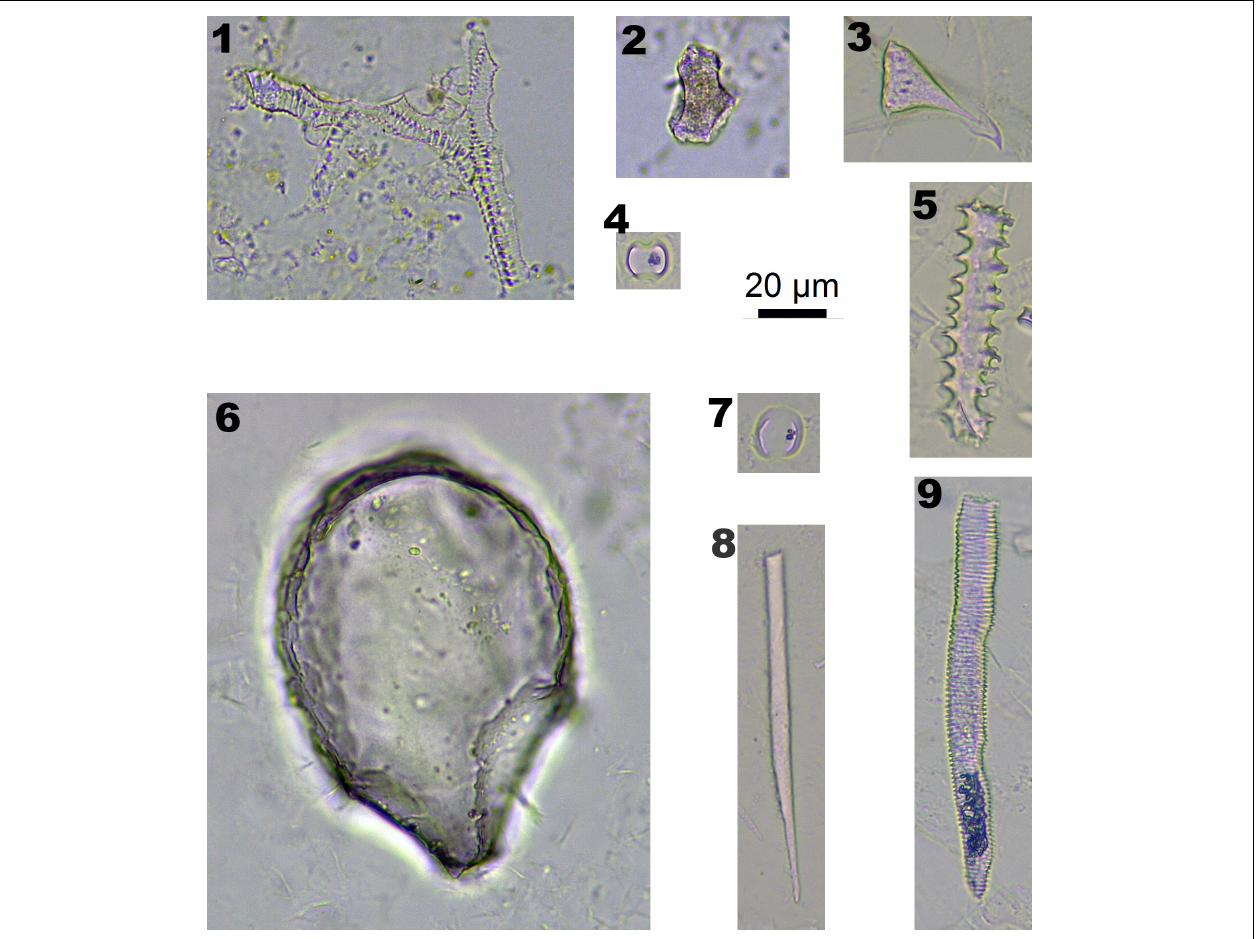
FIGURE 4 | Phytoliths morphotypes in Arundinoideae, Chloridoideae, and Salicaceae. 1. T RACHEARY , in Populus alba ; 2. B LOCKY , in Populus alba ; 3. A CUTE BULBOSUS , in Poaceae and Cyperaceae plants; 4. S ADDLE , in Eragrostis nigra ; 5. E LONGATE ECHINATE , in Poaceae and Cyperaceae plants; 6. B ULLIFORM FLABELLATE , in Phragmites australis ; 7. S ADDLE , in Phragmites australis ; 8. E LONGATE ENTIRE , in Poaceae and Cyperaceae plants; and 9. T RACHEARY ELONGATE , in Poaceae and Cyperaceae